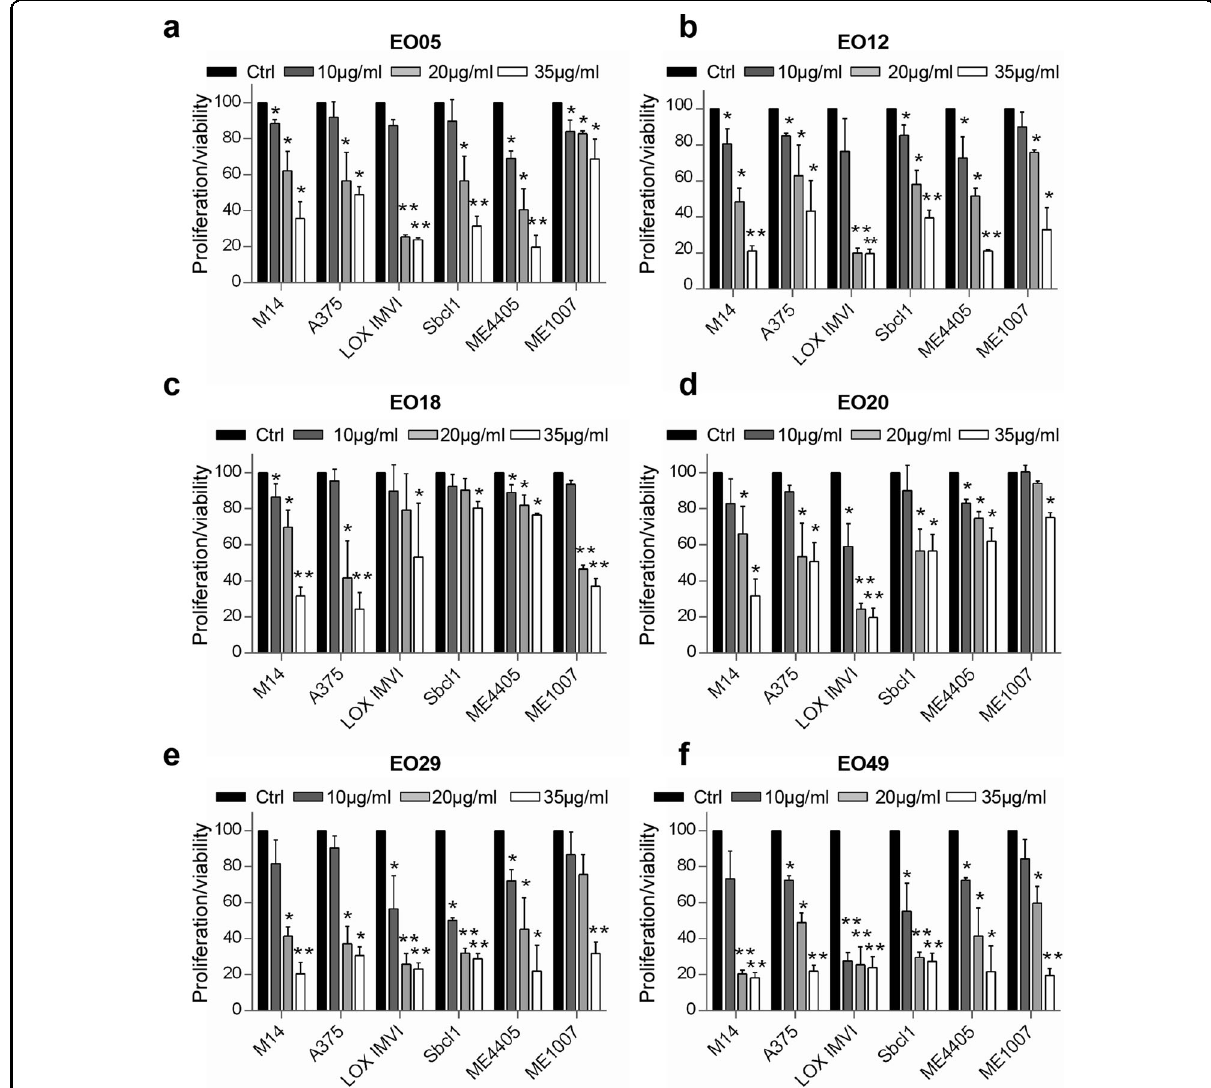
Fig. 2 Six selected EOs affect melanoma cell proliferation/viability. a – f Analysis of cell viability by MTT assay of six melanoma cell lines treated with the indicated EOs (10 – 35 μ g/ml, 48 h). The results are reported as “ cell proliferation-viability of treated cells/cell proliferation-viability of control cells (Ctrl) × 100 ” and represent the average±standard deviation of at least three independent experiments. p -values were calculated between control and EOs treated cells. * p < 0.05; ** p < 0.01 after applying Student ’ s t